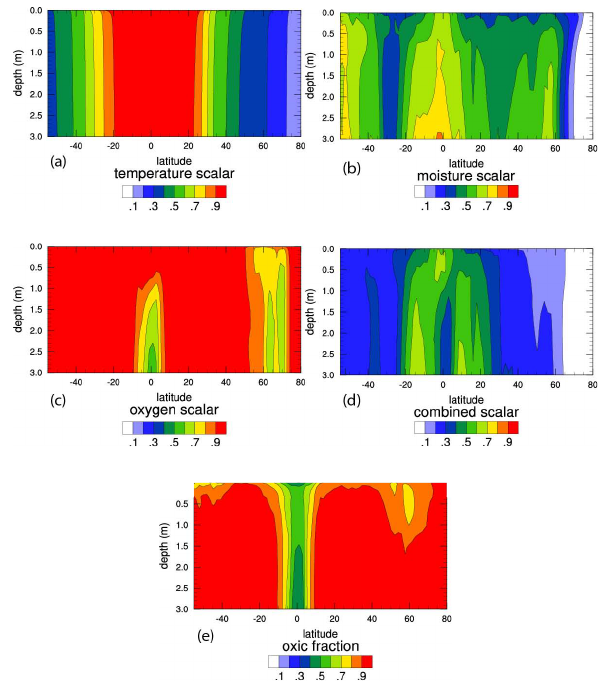
Fig. 11. Zonal- and annual-mean rate limiters for decomposi- tion processes, as function of depth and latitude: (a) temperature scalar ( Q 10 = 1 . 5), (b) moisture scalar (Equation 5), (c) oxygen scalar, (d) combined scalar (not including explicit depth limita- tion)=temp × moist × ox, (e) oxic fraction, following Arah and Vinten